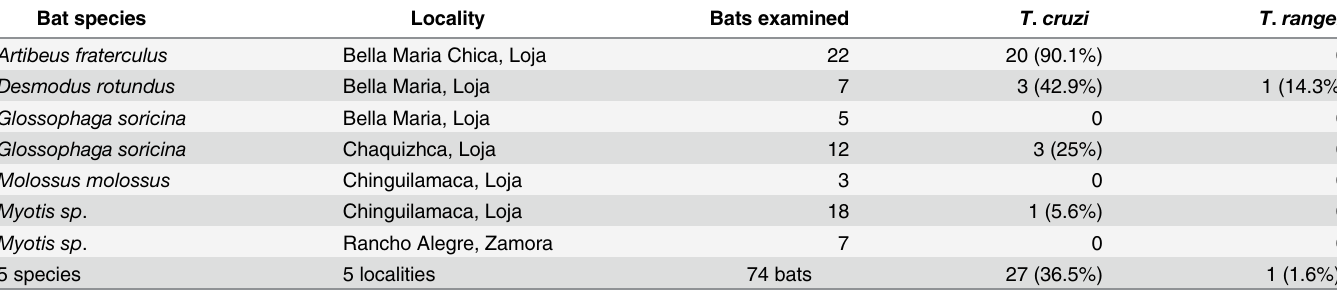
Table 1. Results of PCR screenings for Trypanosoma cruzi and Trypanosoma rangeli .